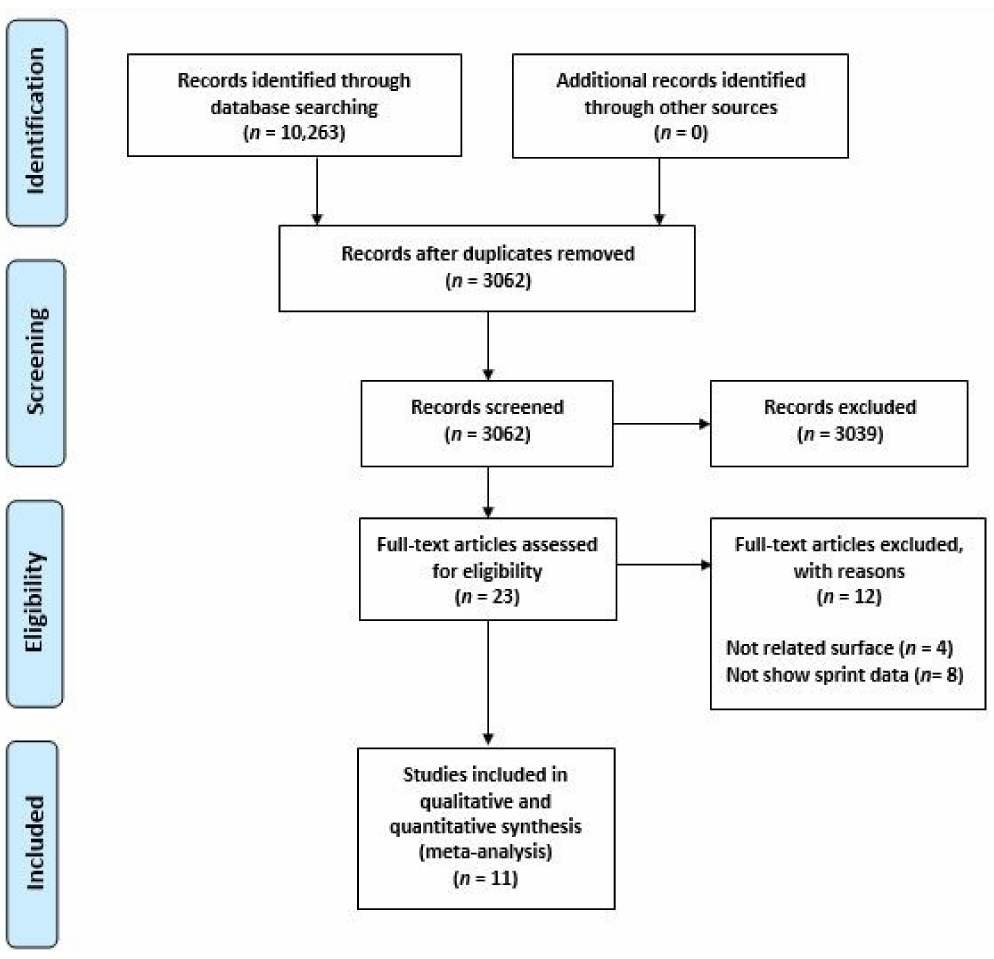
Figure 1. Flow diagram of the